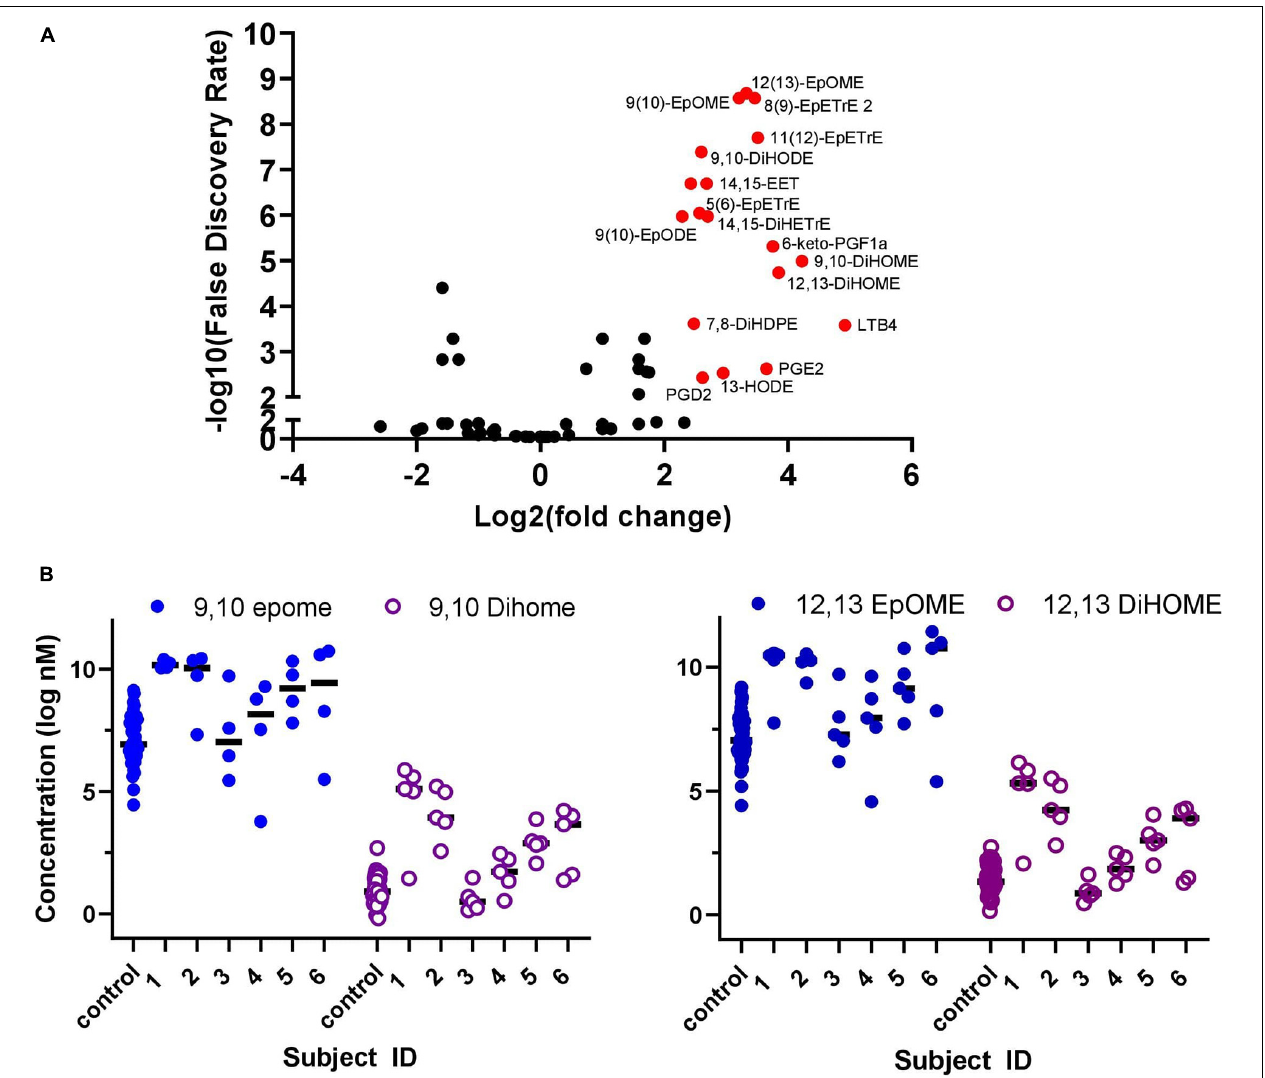
FIGURE 2 | Plasma collected once from healthy COVID-19 negative controls ( n = 44) and over five sequential days from hospitalized COVID-19 positive patients ( n = 6). (A) Volcano plot of oxylipins analyzed in COVID-19 patients compared to healthy controls. Red dots identify metabolites that had a > 4 fold-change and false discovery rate ( p < 0.01), 18 compounds in total. To generate the Volcano plot, data from each COVID-19 patient was averaged over the 5-days before averaging as a group and comparing to the average of all control subject data. (B) Plasma concentration of EpOME and DiHOME in five sequential samples collected from six hospitalized COVID-19 positive patients and control samples collected separately from healthy volunteers ( n = 44). Data from individual days is represented for each COVID patients and for each individual healthy control. The ratio of EpOME:DiHOME, excluding patient #3 who had low levels of both EpOMES and DiHOMES, was higher in control samples vs. COVID-19 patients on day 1 and steadily increased over time in COVID-19 patients. Overall ratios in COVID-19 patients were 30% lower than healthy controls indicating that DiHOMES increased in greater amounts compared to EpOME (graphical representation of raw data is included in Supplementary Figure 1